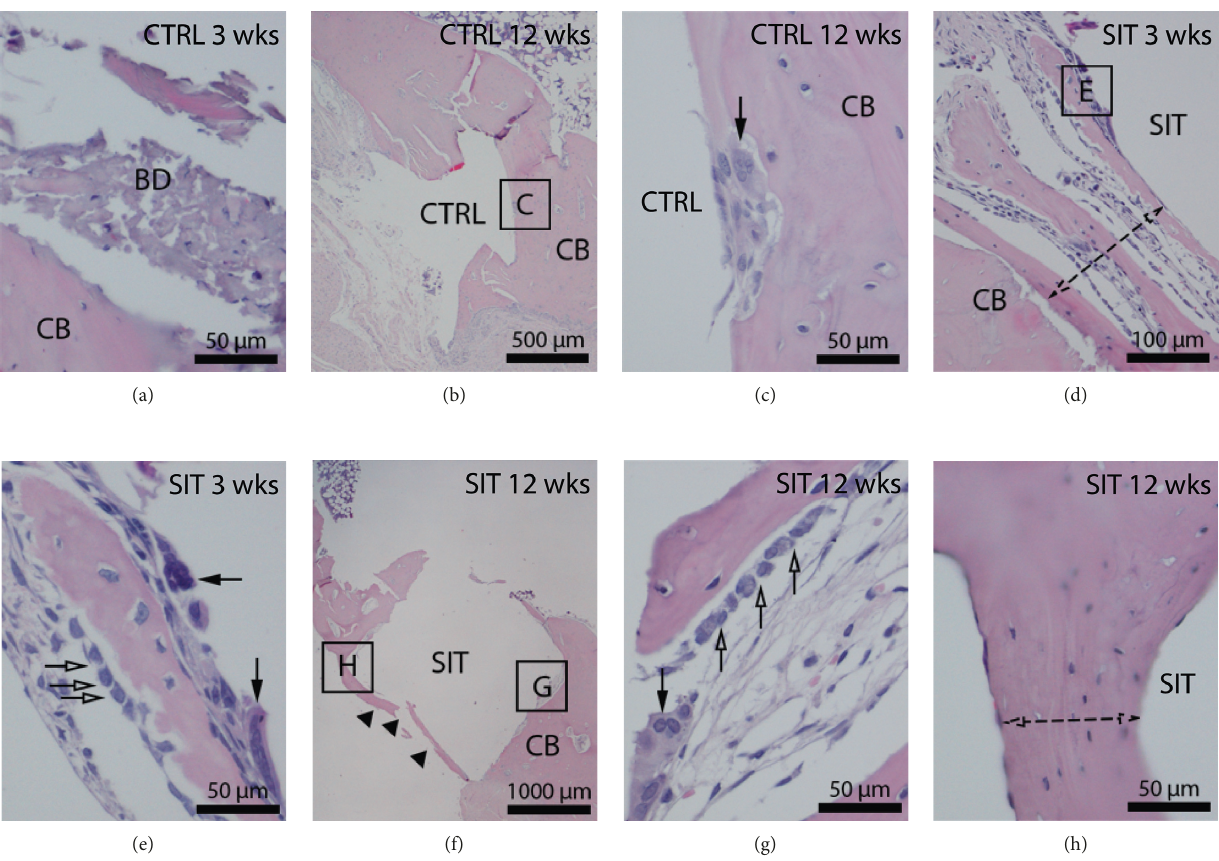
Figure 4: H&E staining highlights histological changes in the tibial bone after implantation of the SIT implant (d, e, f, g, h) or control implant (a, b, c) for a duration of 3 weeks (a, d, e) or 12 weeks (b, c, f, g, h). The metal implants have been removed. (a) At 3 weeks post implantation, bone debris is present between the control implant and cortical bone. (b) At 12 weeks post implantation, the cortical bone surrounding the control implant has active bone remodeling at the bone-metal interface (c) which involves osteoclasts (arrow). However, the cortical bone is being actively remodeled (double-headed arrow) around the site of the SIT implant (d) after 3 weeks. At higher magnification (e), multinucleated osteoclasts (black arrows) and hypertrophied osteoblasts (white arrows) participate in bone remodeling. (f) At 12weeks post implantation, the SIT implant is encased in the cortical bone (arrowheads) which at higher magnification (h) has the morphology of a mature bone (double-headed arrow). The remodeling of the bone surrounding the SIT implant is still active (g) and involves osteoclasts (black arrow) and hypertrophied osteoblasts (white arrows). CTRL (cid:136) control, SIT (cid:136) stemmed implant, CB (cid:136) cortical bone, and BD (cid:136) bone